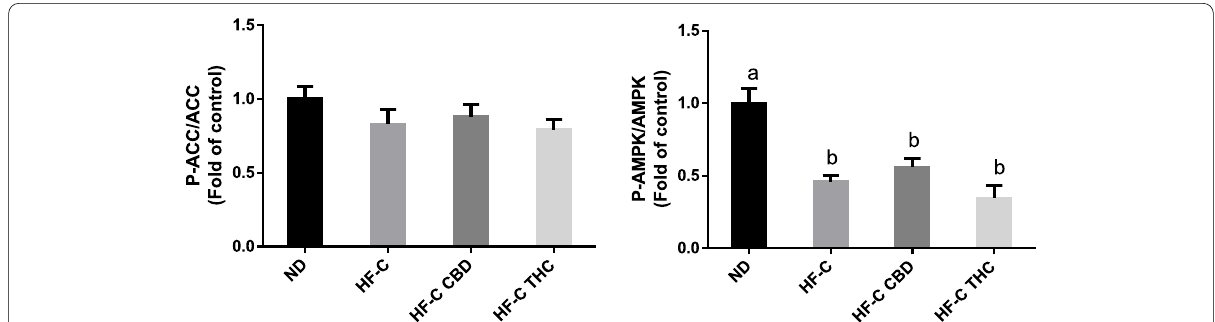
Fig. 6 Effect of THC or CBD treatment on phosphorylation of carbohydrate and lipid metabolism‑related proteins in mice fed HFCD. Male C57BL/6J mice aged 7–8 weeks were fed either normal diet (ND, n 8), high fat 1%(w/w) cholesterol 0.5%(w/w) cholate diet (HF‑C, n 8), HFCD = + + = containing CBD (2.39 mg/kg) (HF‑C CBD, n 8), HFCD containing THC (2.5 mg/kg) (HF‑C THC, n 8). At the conclusion of the experiment, total = = protein was isolated from harvested livers and phosphorylated protein levels quantified. Values are expressed as phosphorylated/total protein ratio compared to ND SEM. Values marked with different letters are significantly different ( p < 0.05) in the Tukey–Kramer test ±